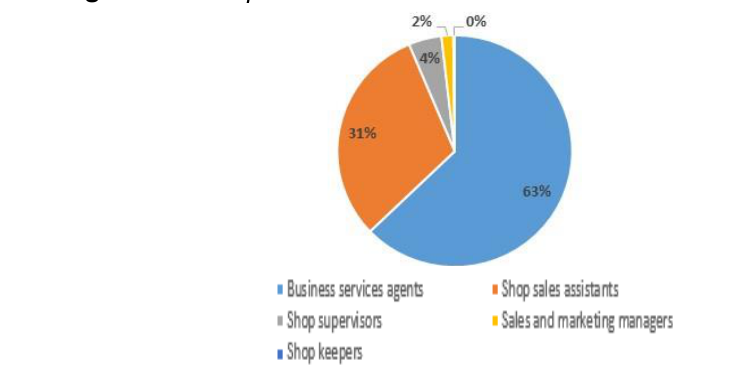
Figure 1: Occupation Profiles of Vacancies in area